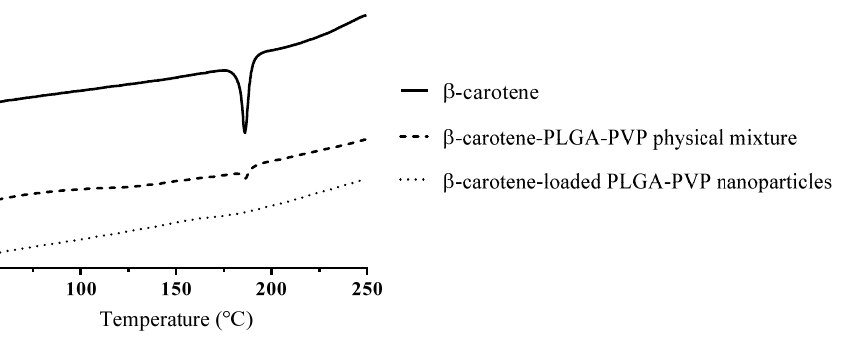
Figure 5. DSC thermograms of β -carotene, a β -carotene-PLGA-PVP physical mixture, and β -carotene-loaded PLGA-PVP nanoparticles.